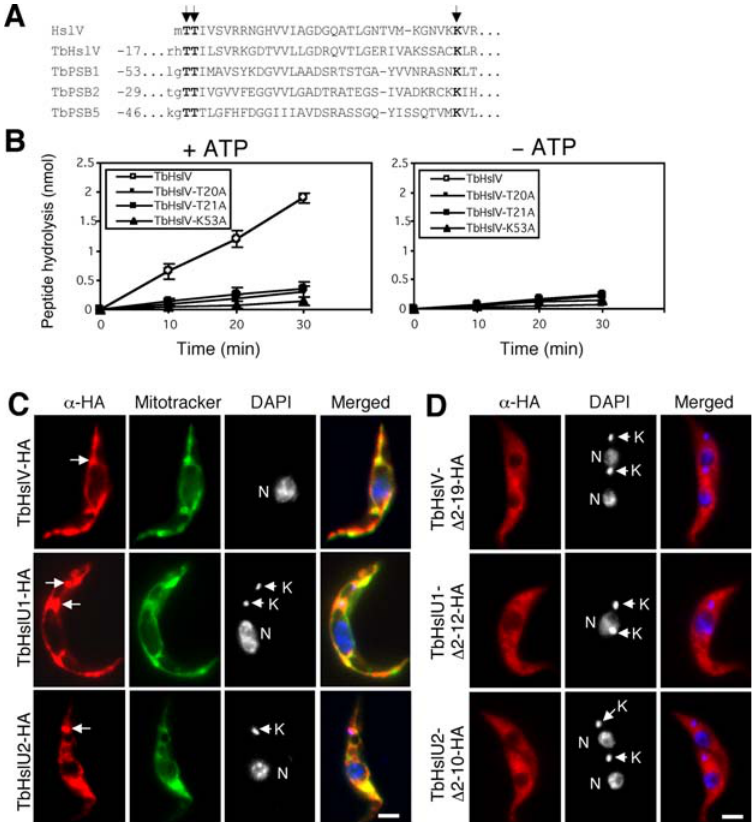
Figure 1. Enzymatic activity and intracellular localization of TbHslVU. ( A ). TbHslV contains the conserved threonine and lysine residues (arrows) found essential for the activities of HslV in E. coli [6] and the b -subunits of 20S CP in T. brucei [54]. ( B ). The ATP-dependent peptidase activity of TbHslV. Wild type and three TbHslV mutants T20A, T21A and K53A were expressed as HA-tagged proteins in T. brucei , immunoprecipitated and assayed for hydrolysis of Cbz-Gly-Gly-Leu-AMC. ( C ). Cells stably expressing TbHslVU-HA were labeled for mitochondria with Mitotracker green dye (green), immunostained with anti-HA mAb for HA-tagged proteins (red) and counterstained with DAPI for DNA (blue). Arrows indicate the focal points of HA-staining corresponding to the positions of kinetoplasts (arrowheads). ( D ). Cells expressing TbHslVU-HA with the putative mitochondrial targeting sequences deleted were stained with anti-HA antibody (red) and counterstained with DAPI. Bars: 2 m m.